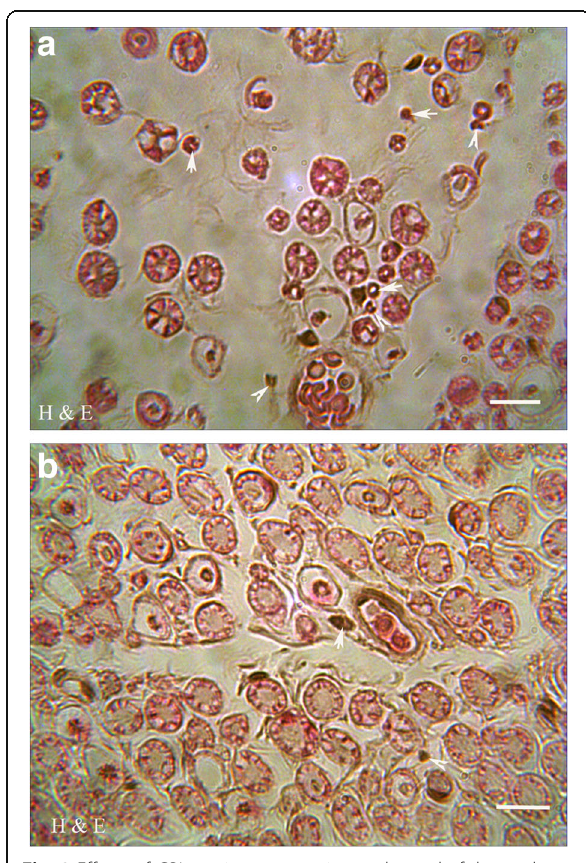
Fig. 3 Effects of GRL on tissue protection at the end of the study (8th week). Photomicrographs of sciatic horizontal section of STZ group ( a ) with degeneration of the myelin sheath (arrows) and numerous infiltrated inflammatory cells (arrowheads) among the separated nerve fibers, and STZ plus GRL groups ( b ) with only focal loss of myelin sheath (arrows) and a few scattered inflammatory cells (arrowheads) (stained with hematoxylin and eosin; original magnification: ×400, bar: 250 μ